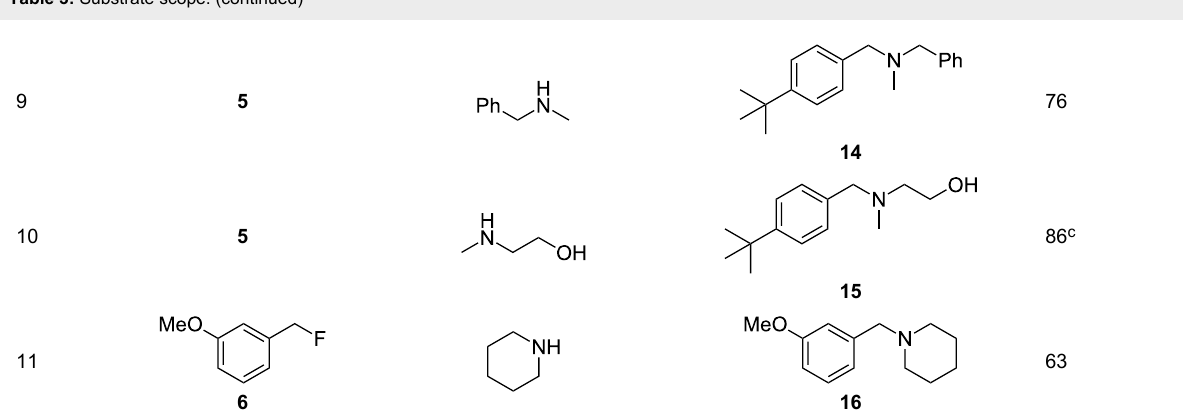
Table 3: Substrate scope.